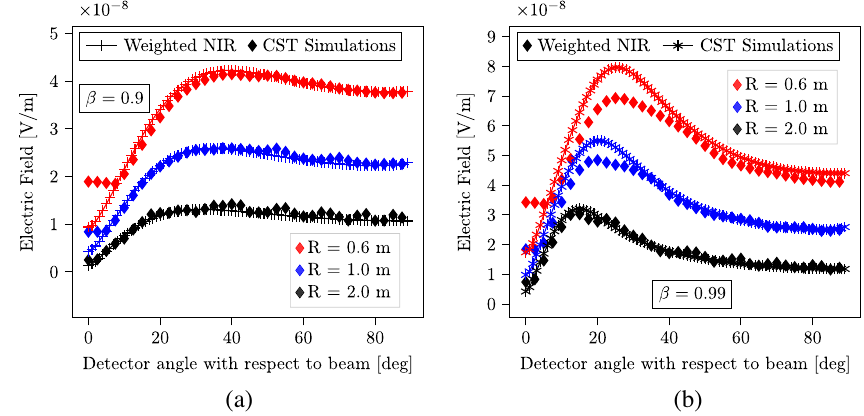
FIG. 12. The angular distribution for the peak field obtained for a 100 ps bunch at β ¼ 0 . 9 and β ¼ 0 . 99 as a function of monitor distance from the target. The target size is set to 1 . 4 βγλ for the reference wavelength of λ ¼ 1